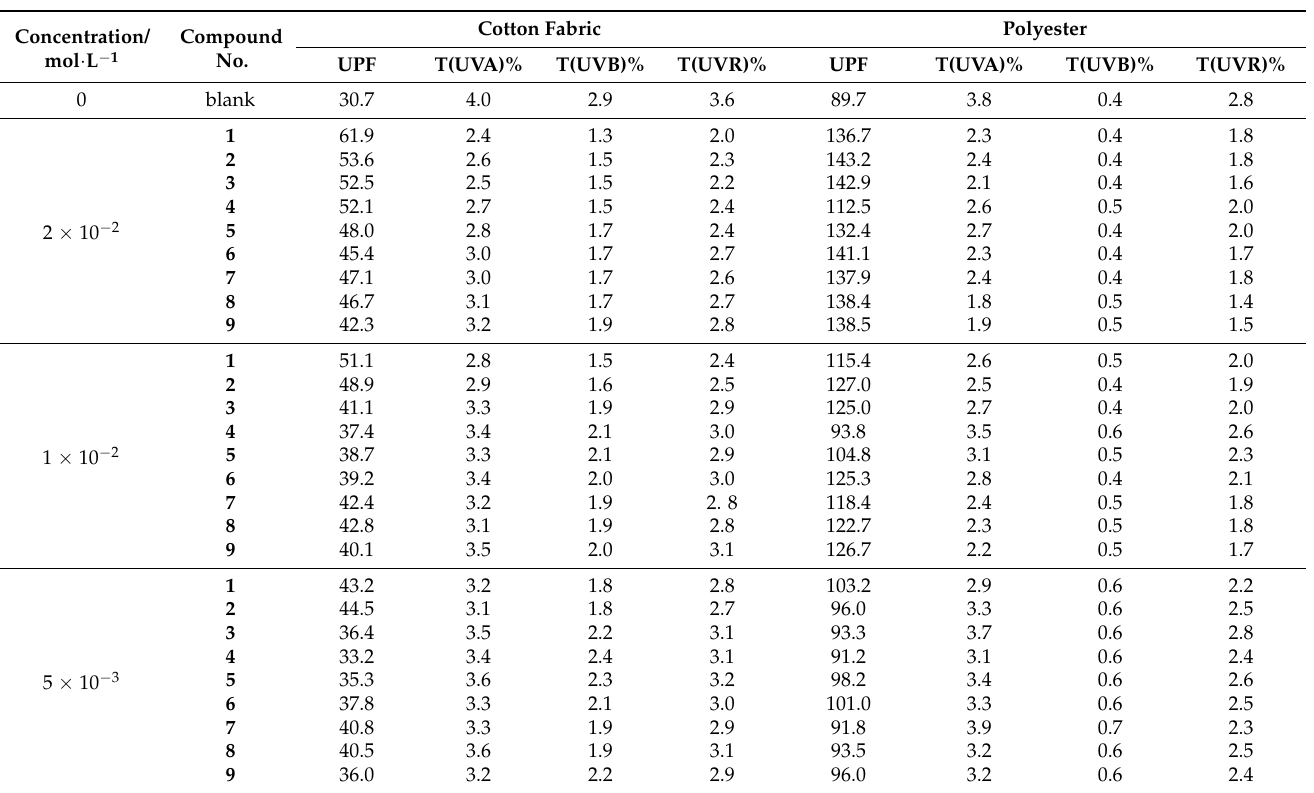
Table 1. UV resistance of